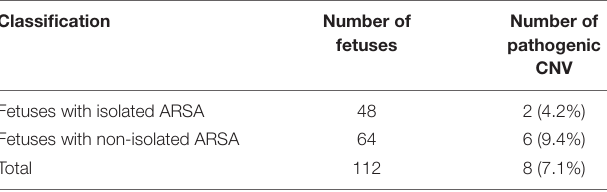
TABLE 4 | Phenotypic characteristics of 112 fetuses with